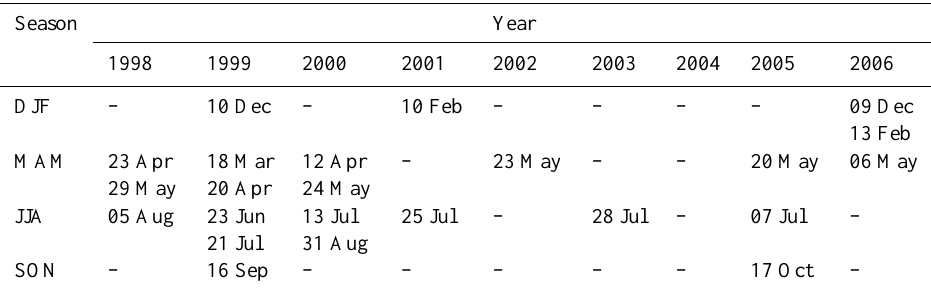
Table 4. Overview of the University of Wyoming ballon-borne optical particle counter (OPC) measurements, at Laramie (WY, 41.3 ◦ N, 105.7 ◦ W; Deshler et al., 2003a) between 1998 and 2006.